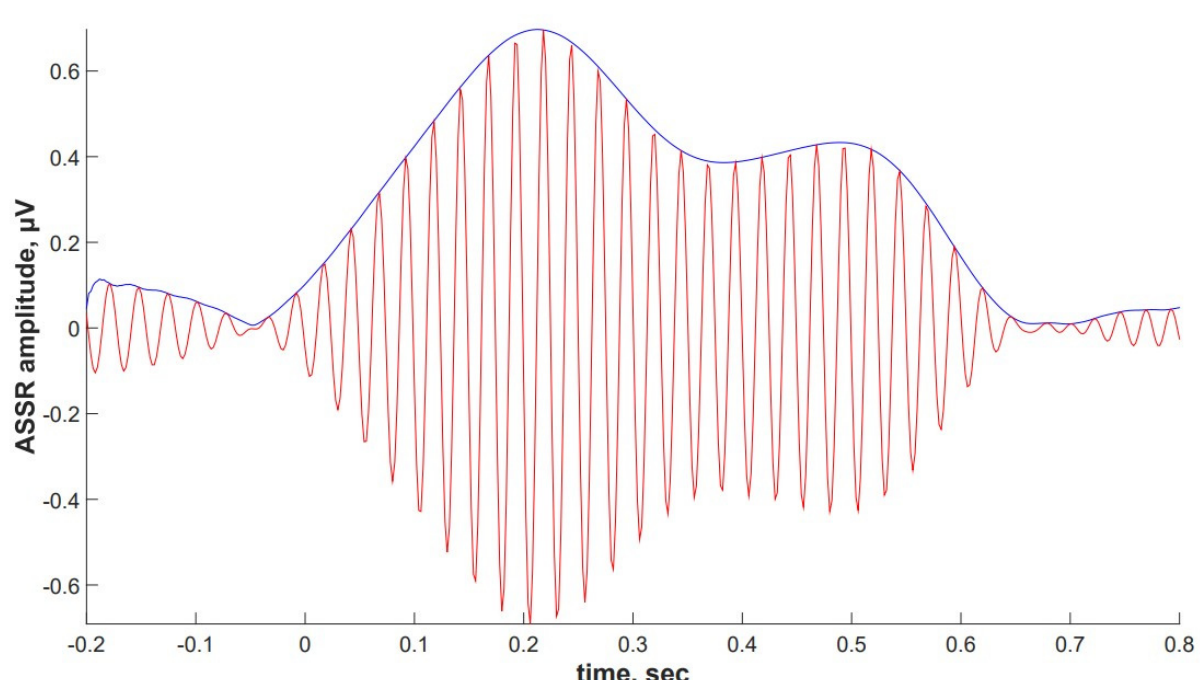
3 of 18 Figure 7. ERPs components across groups. P1 component is shown in ( a ), N1 is shown in ( b ), P2 is shown in ( c ). The old typically developing (TD) group’s values are shown in the first column, the young TD’s values are shown in a second, and